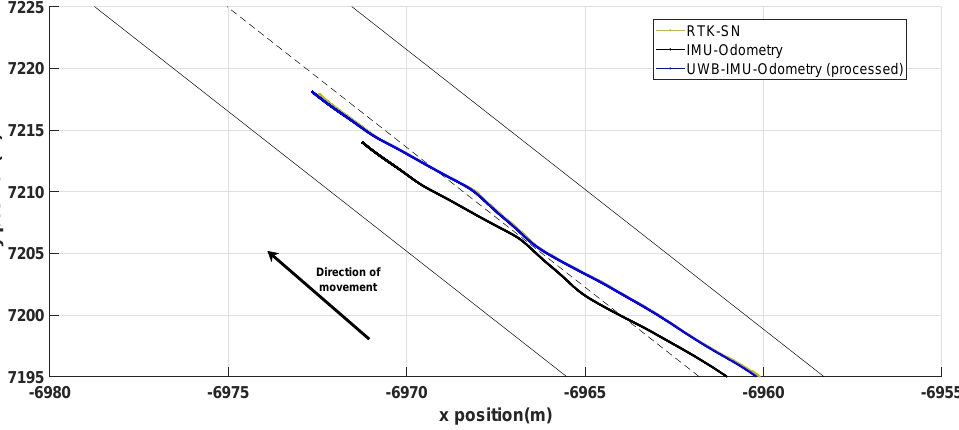
Figure 14. Comparison of the different trajectories at the end of the experiment.